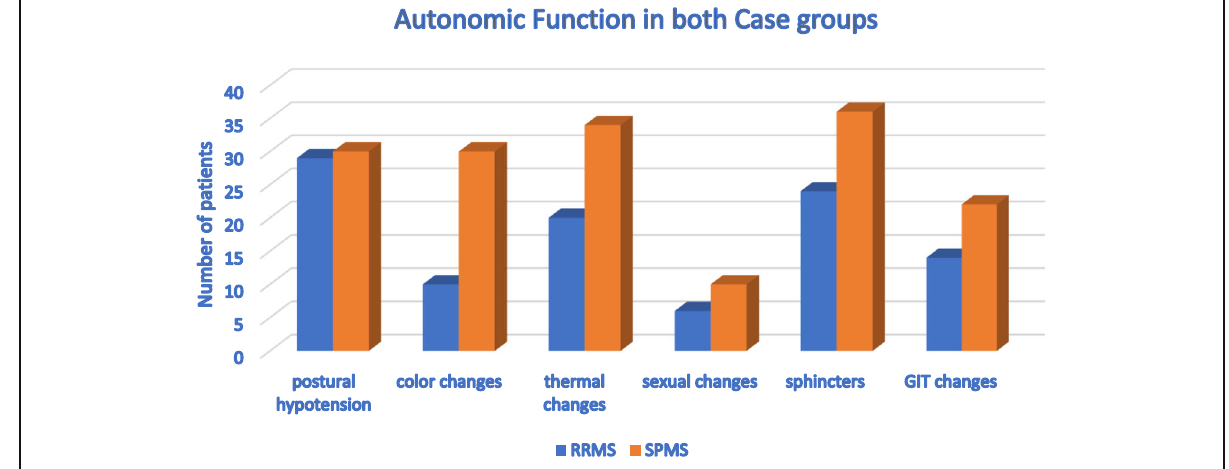
Fig. 2 Assessment of autonomic function between 2 case